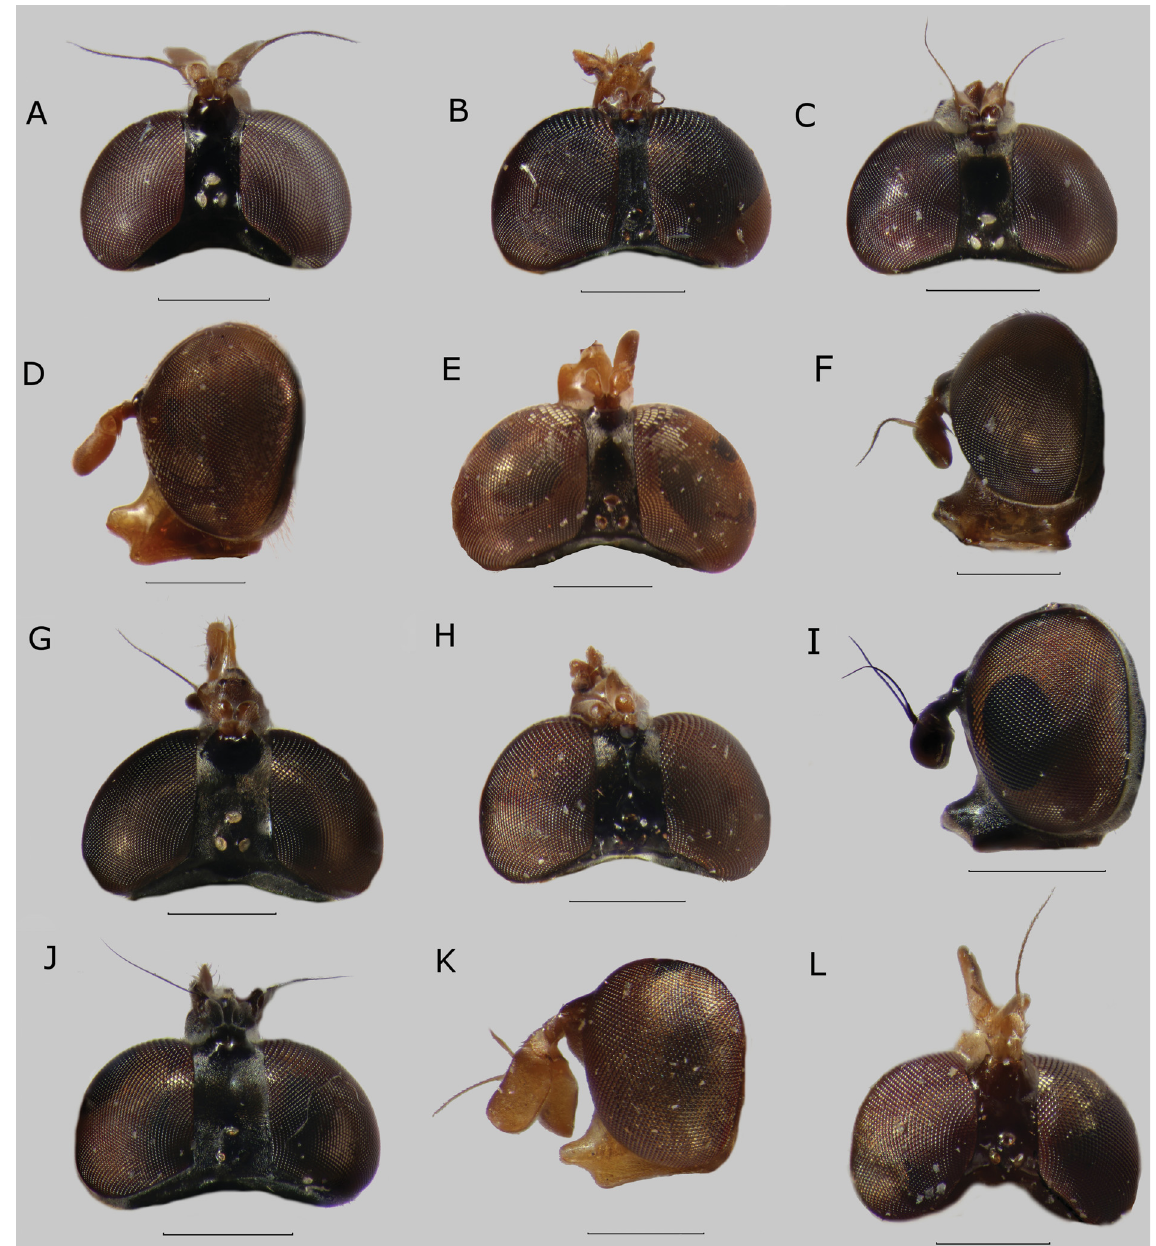
Fig. 54. Head, lateral view (D, F, I, K) and dorsal view (A–C, E, G–H, J, L). A . Sphegina (Asiosphegina) incretonigra sp. nov., holotype, ♂ , Vietnam. B . S. (A.) in fl ata sp. nov., holotype, ♂ , Philippines. C . S. (A.) inventum sp. nov., paratype, ♀ , Sabah, Malaysia. D–E . S. (A.) karnataka sp. nov., paratype, ♂ , India. F–G . S. ( A. ) licina sp. nov., holotype, ♂ , Thailand. H . S. (A.) lucida sp. nov., paratype, ♂ , Vietnam. I–J . S. (A.) nigerrima Shiraki, 1930, ♂ , Taiwan. K–L . S. ( A.) nigrotarsata sp. nov., paratype, ♂ , Vietnam. Scale bars = 0.5